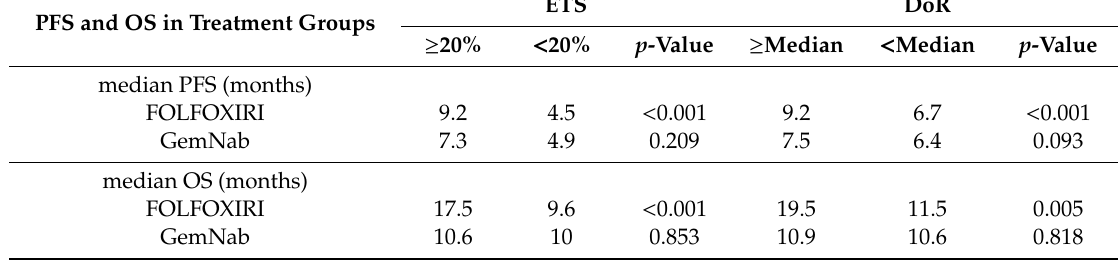
Table 4. Median OS and PFS with respect to ETS and DoR in the two treatment groups.